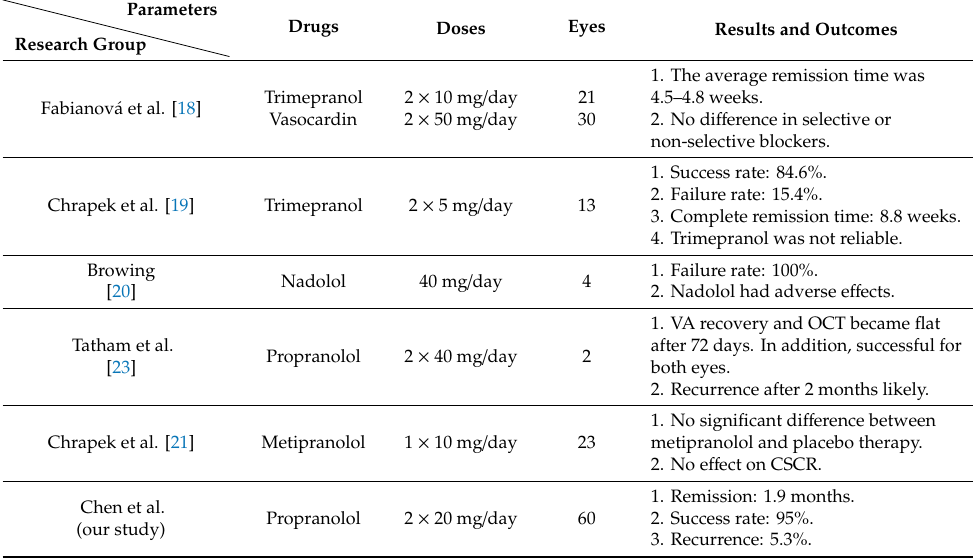
Table 3. A comparison of various beta-blockers in treating central serous